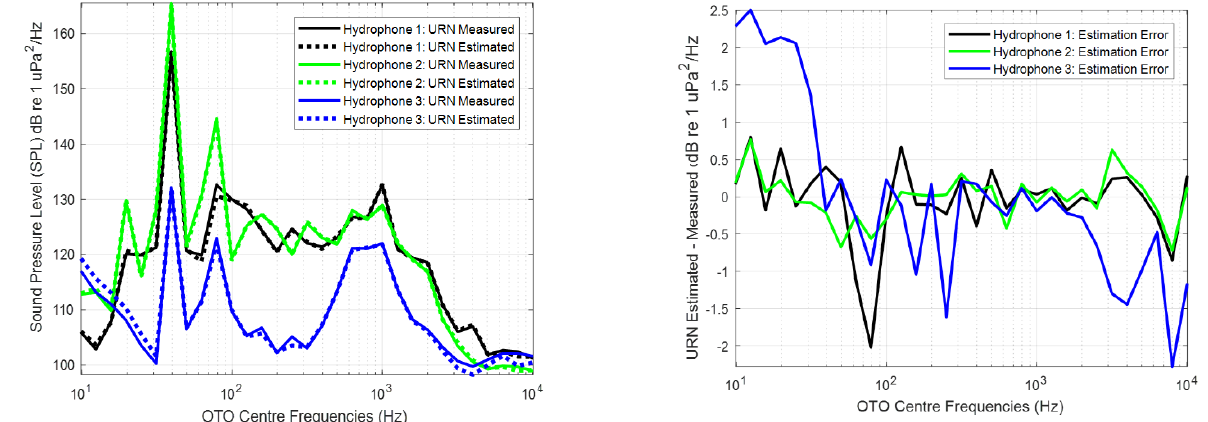
Figure 11. Measured and estimated Sound Pressure Level ( 𝑆𝑃𝐿 ) or Underwater Radiated Noise (URN) using the Transfer Function for each hydrophone ( left ) and differences between them ( right ).